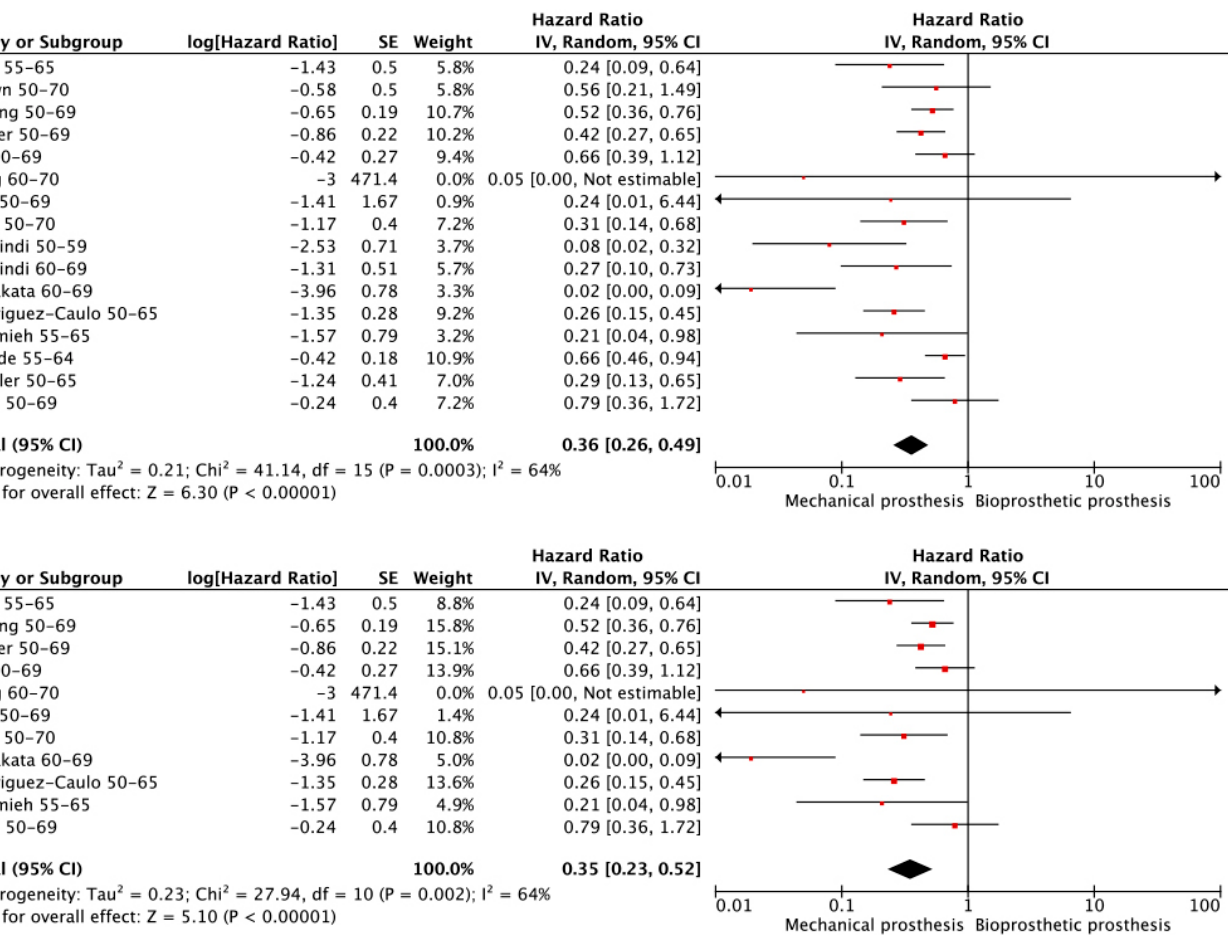
Figure 5A. Bioprosthetic vs. mechanical (RCT or PSM)—HR: 0.35; 95% CI: 0.23–0.52, Fig ‐ ure 5B).